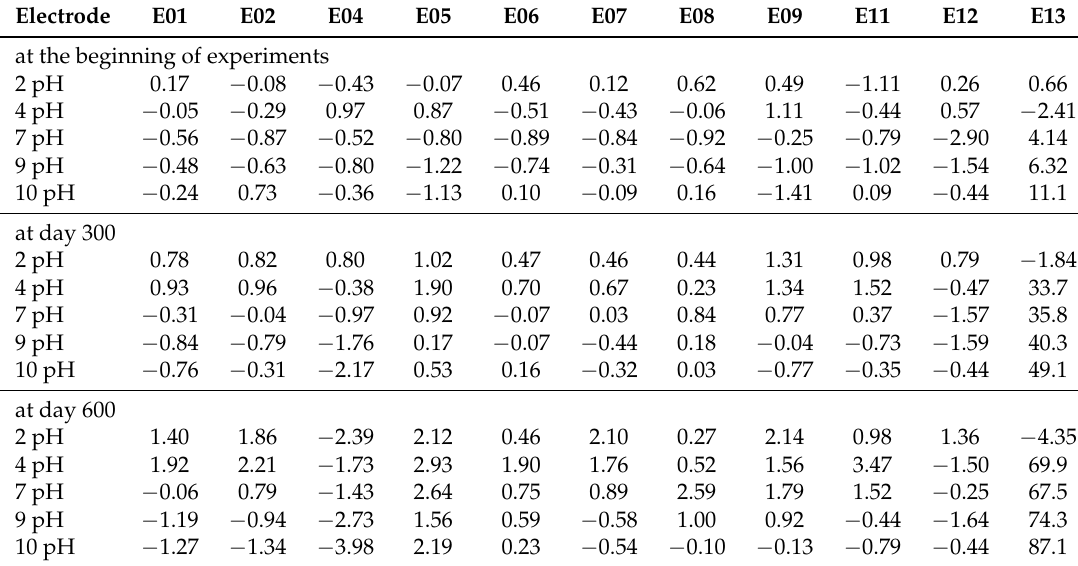
Table 7. Approximated values of the electrode potential hysteresis (in mV) in buffer